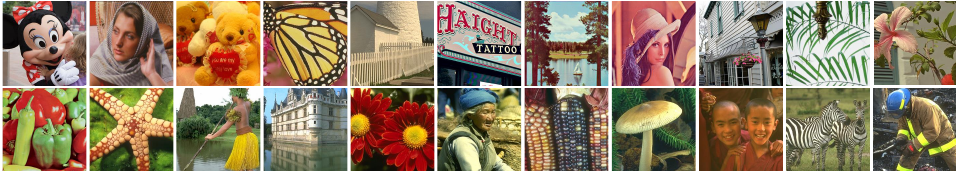
Figure 1. The 22 color images used in our experiments. Top row, from left to right: Mickey, Barbara, Bear, Butterfly, Fence, Haight, Lake, Lena, Light, Leaves, Lily. Bottom row, from left to right: Pepper, Starfish, Man, Tower, Flowers, Nanna, Corn, Agaric, Monk, Zebra,